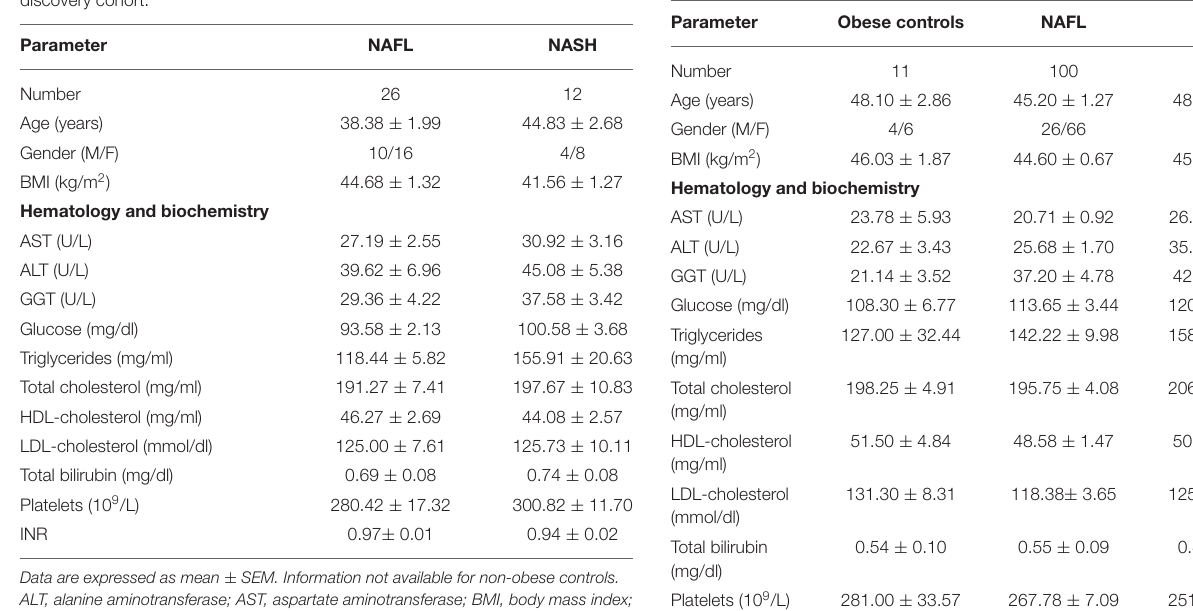
TABLE 2 | Patient demographic, clinical and laboratory data for validation cohort.